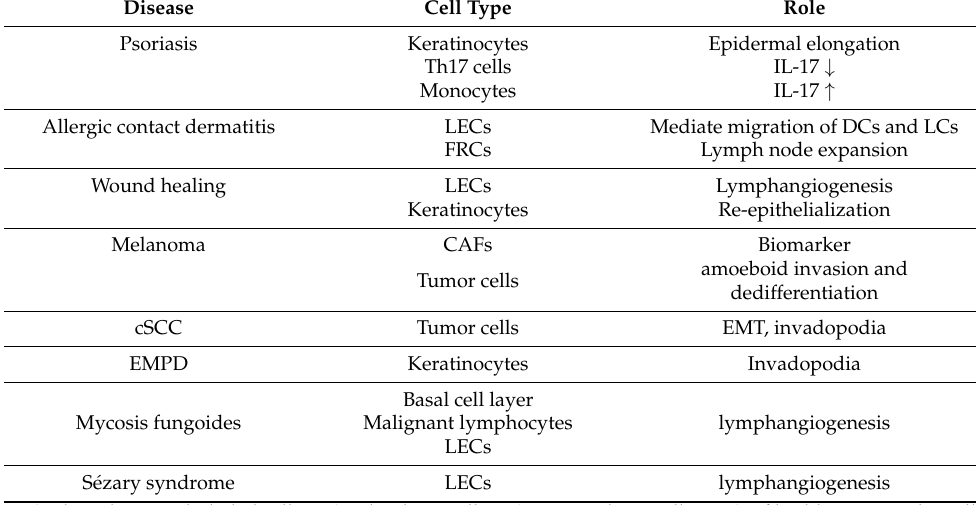
Table 1. Role of podoplanin-expressing cells in skin diseases. Disease Cell Type Role